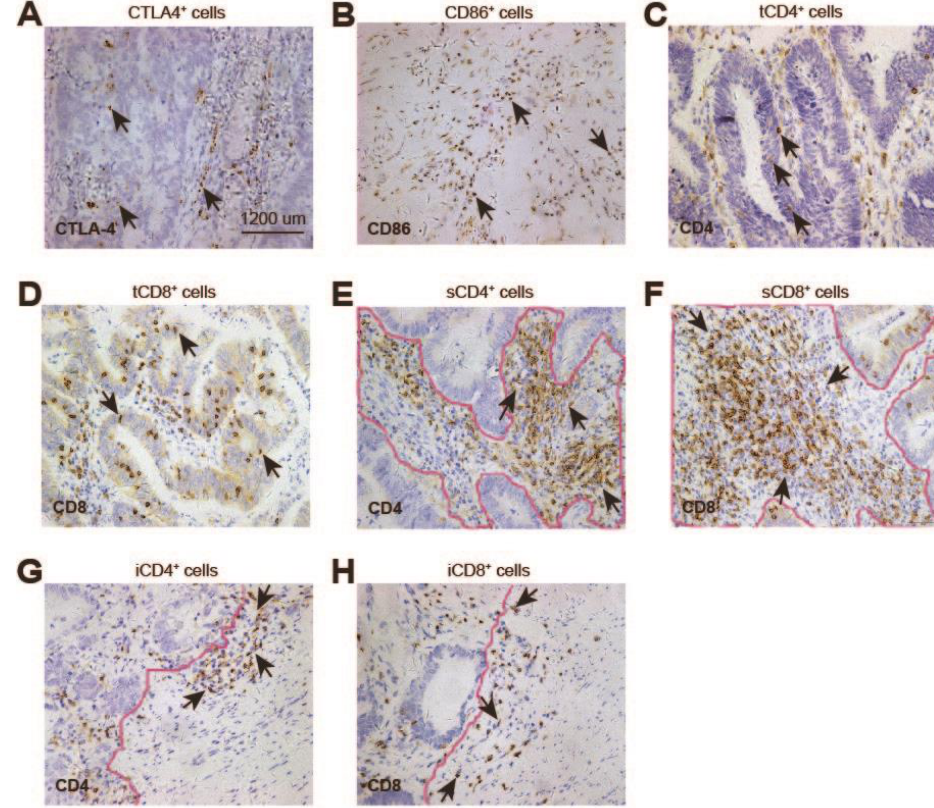
Figure 1. Immunohistochemical staining of immune-related molecules. ( A ) CTLA-4 + cells were detected on the stroma and tumor. ( B ) The expression of CD86 was detected on the lymphocytes. ( C – H ) CD8 and CD4 positive cells were divided into tCD8 + /tCD4 + cells (lymphocytes on the tumors, ( C , D )), sCD8 + /sCD4 + cells (lymphocytes on the stroma where the curve labeled, ( E , F )), and iCD8 + /iCD4 + cells (lymphocytes on the invasive front, ( G , H )).